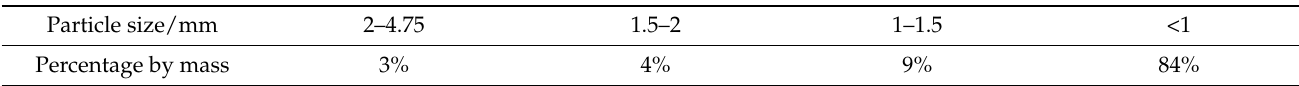
Table 2. Grading of RS. Table 1. Chemical composition of raw materials, in weight %.